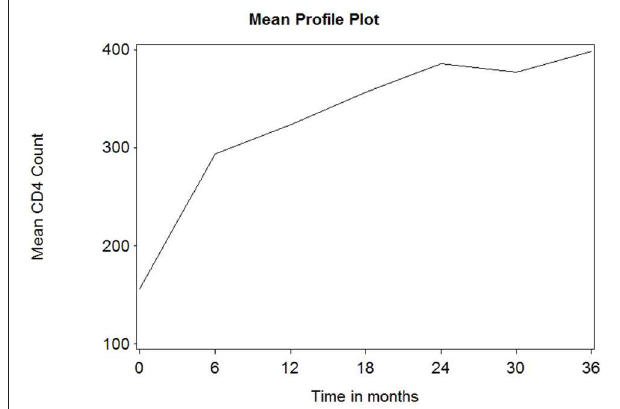
FIGURE 2 | The overall mean profile plot of CD4 cell count.